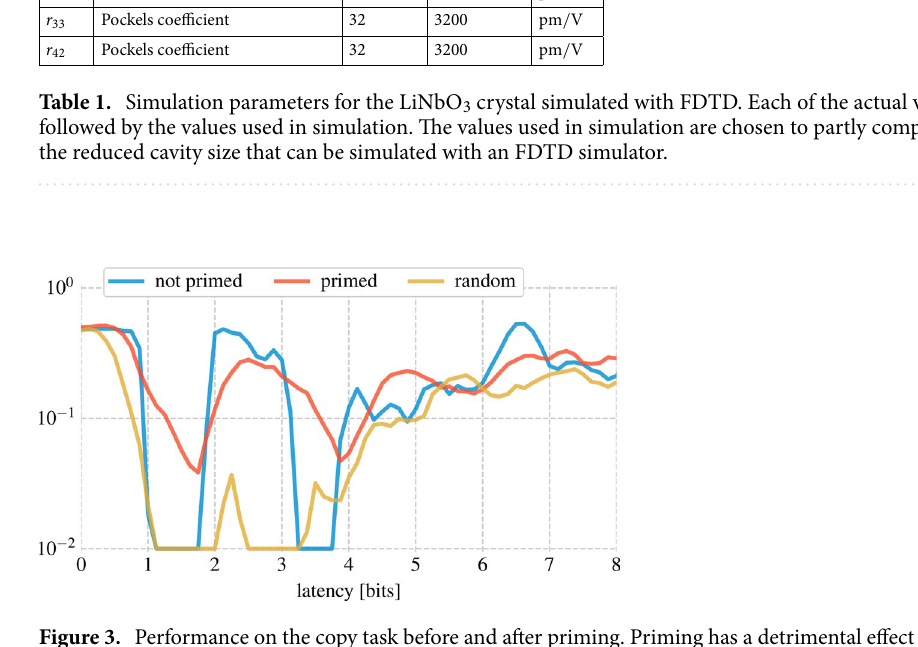
Figure 3. Performance on the copy task before and after priming. Priming has a detrimental effect on the memory of the reservoir. The latency is increased in steps of 0.125